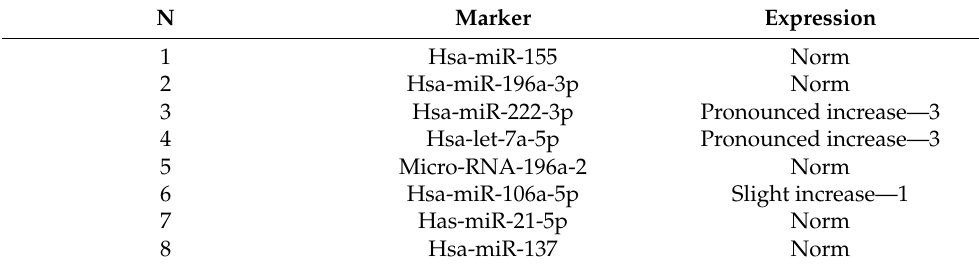
Table 3. miRNA expression in patient P after 6